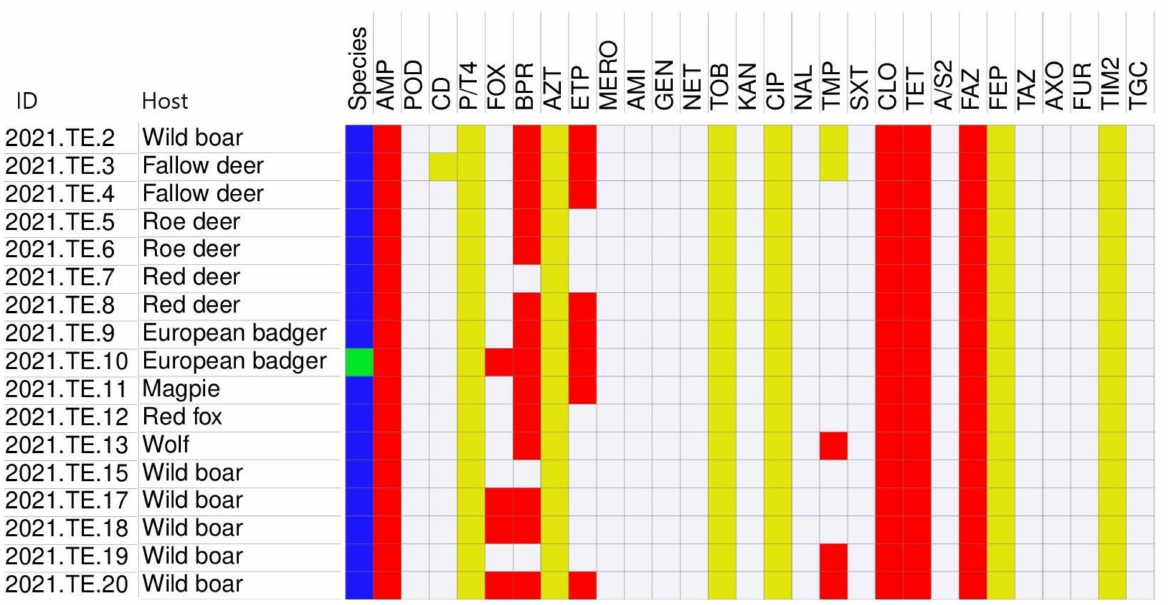
Figure 2. Heatmap encompassing antimicrobial susceptibility testing results of K. pneumoniae strains (blue) and K. quasipneumionae strain (green). Red color indicates resistance, yellow indicates an intermediate phenotype, and white indicates susceptibility. AMP: ampicillin, POD: cefpodoxime, CD: